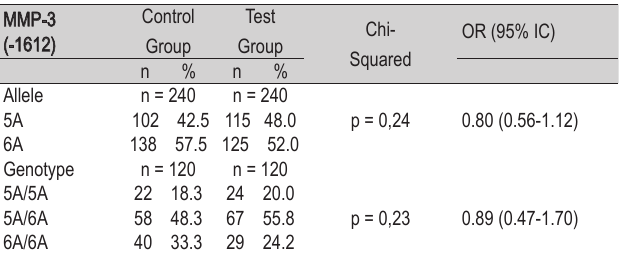
Table 1 - Distribution of the MMP-3 allele and genotype in the control and test